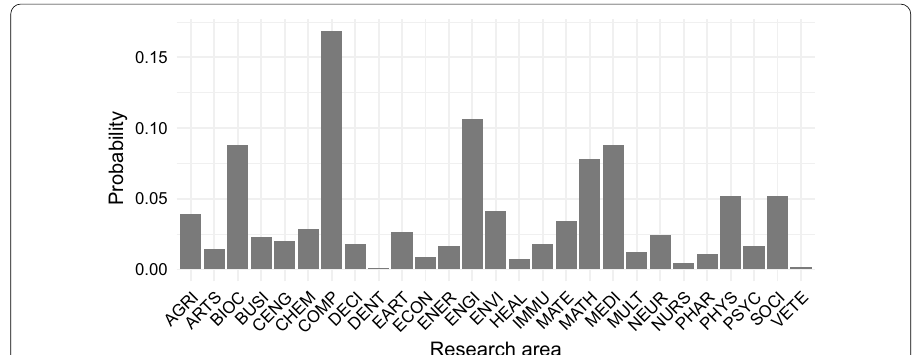
Fig. 2 Distribution of the research areas covered by the authors in our dataset